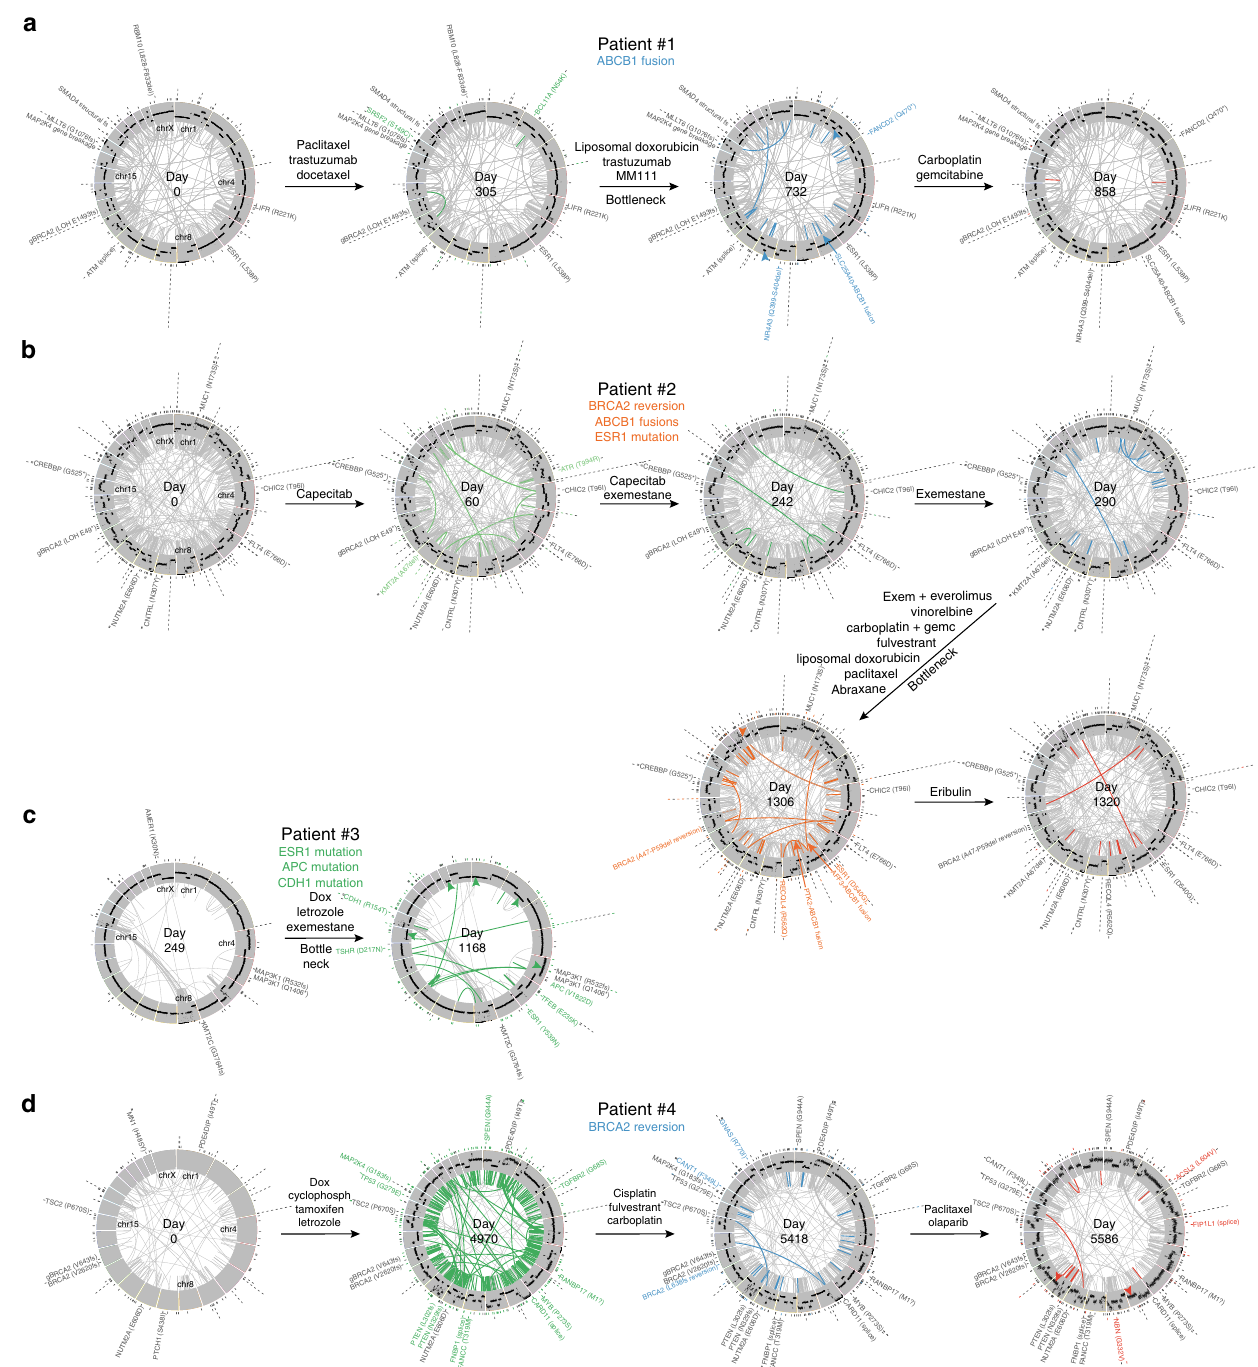
Fig. 3 SNV, structural variant, and CNA evolution in four breast cancers. a – d Circos plots showing mutation evolution of breast cancer patients #1 to #4 through treatment. Each circle represents chromosomes 1 through X (clockwise from top) arranged in a circle. Protein-coding somatic SNVs and indels are indicated outside each circle as ticks or, for Cancer Gene Census genes, by name. Germline BRCA2 mutations are indicated as “ gBRCA2. ” Structural variants (large deletions, translocations, inversions, and duplications) are indicated inside each circle as a line joining the start and end of the variant, with Cancer Gene Census gene mutations indicated outside. Copy number changes are represented in the gray region with higher copy towards the outer edge. Newly appearing SNVs, indels, and structural variants are shown in color, while selected newly appearing CNAs are indicated by colored arrows. CNAs were not determined in the patient #4 day 0 sample due to technical issues with FFPE